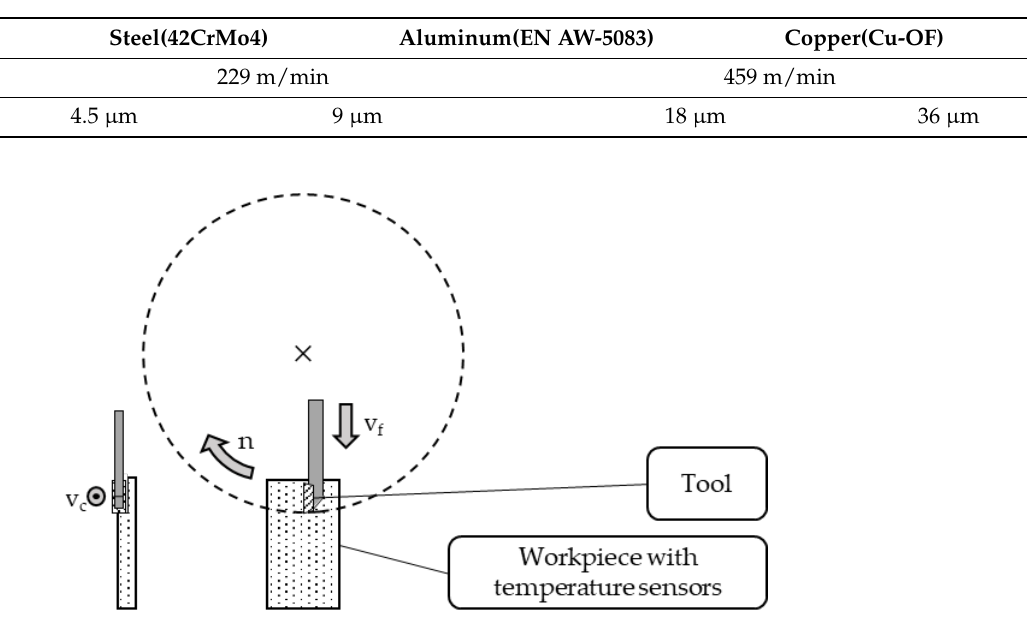
Table 1. Variation of workpiece materials and process parameters.